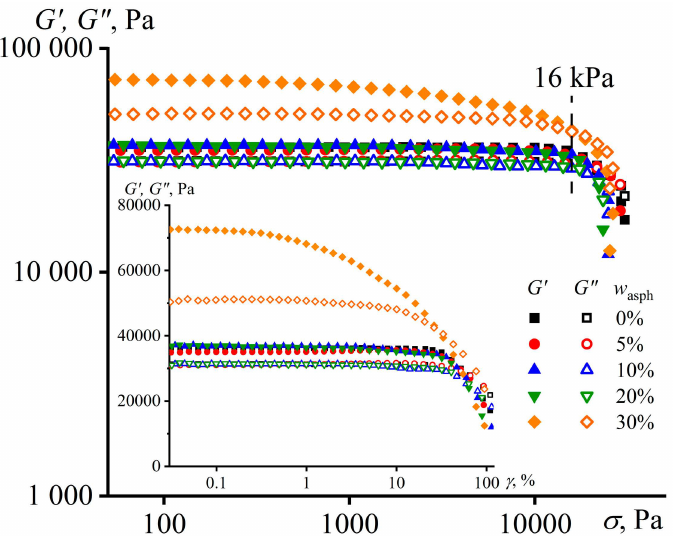
Figure 7. The dependences of storage and loss moduli on shear stress for PIB and its mixtures with different content of asphaltenes at an angular frequency of 6.28 rad/s and 25 ◦ C. The insert shows the same results but as a function of